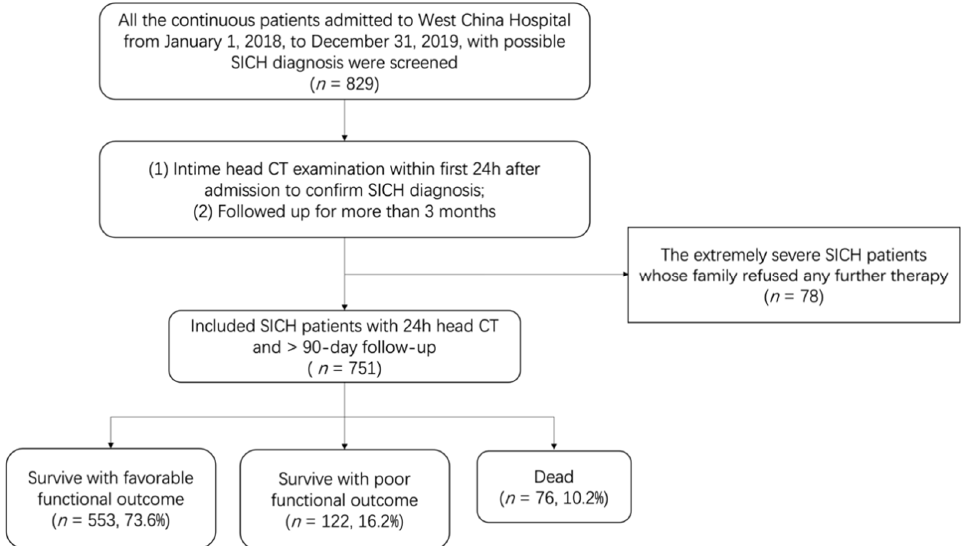
Figure 1. Flowchart of SICH patient inclusion and exclusion.